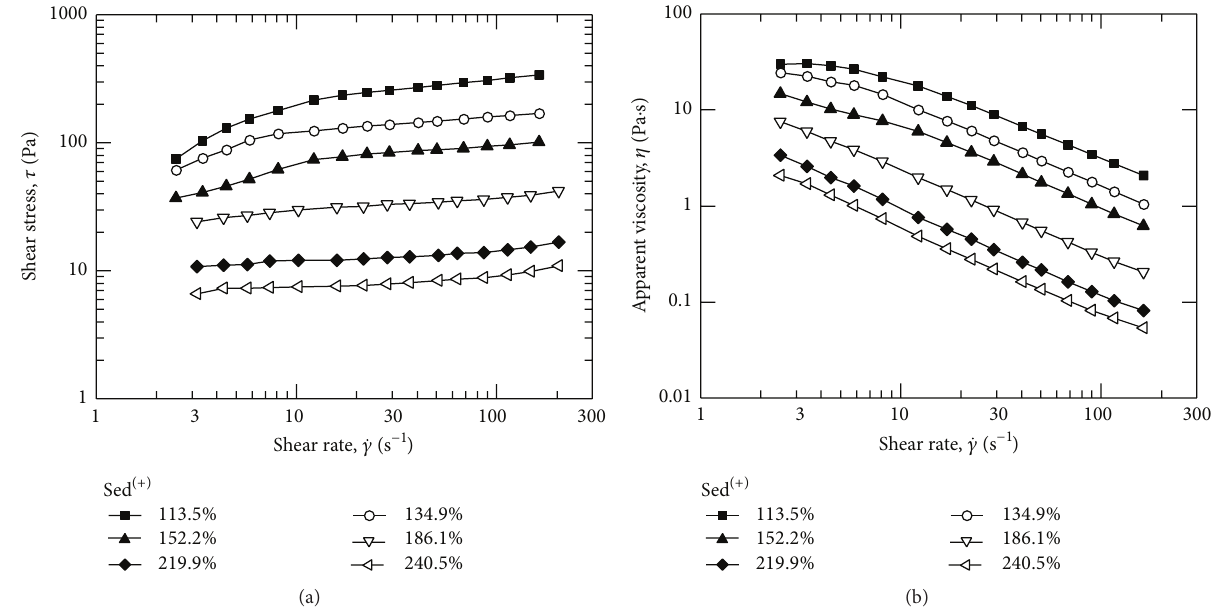
Figure 2: The variation of typical flow curves with water content. (a) Plot of log shear stress versus log shear rate. (b) Plot of log apparent viscosity versus log shear rate.